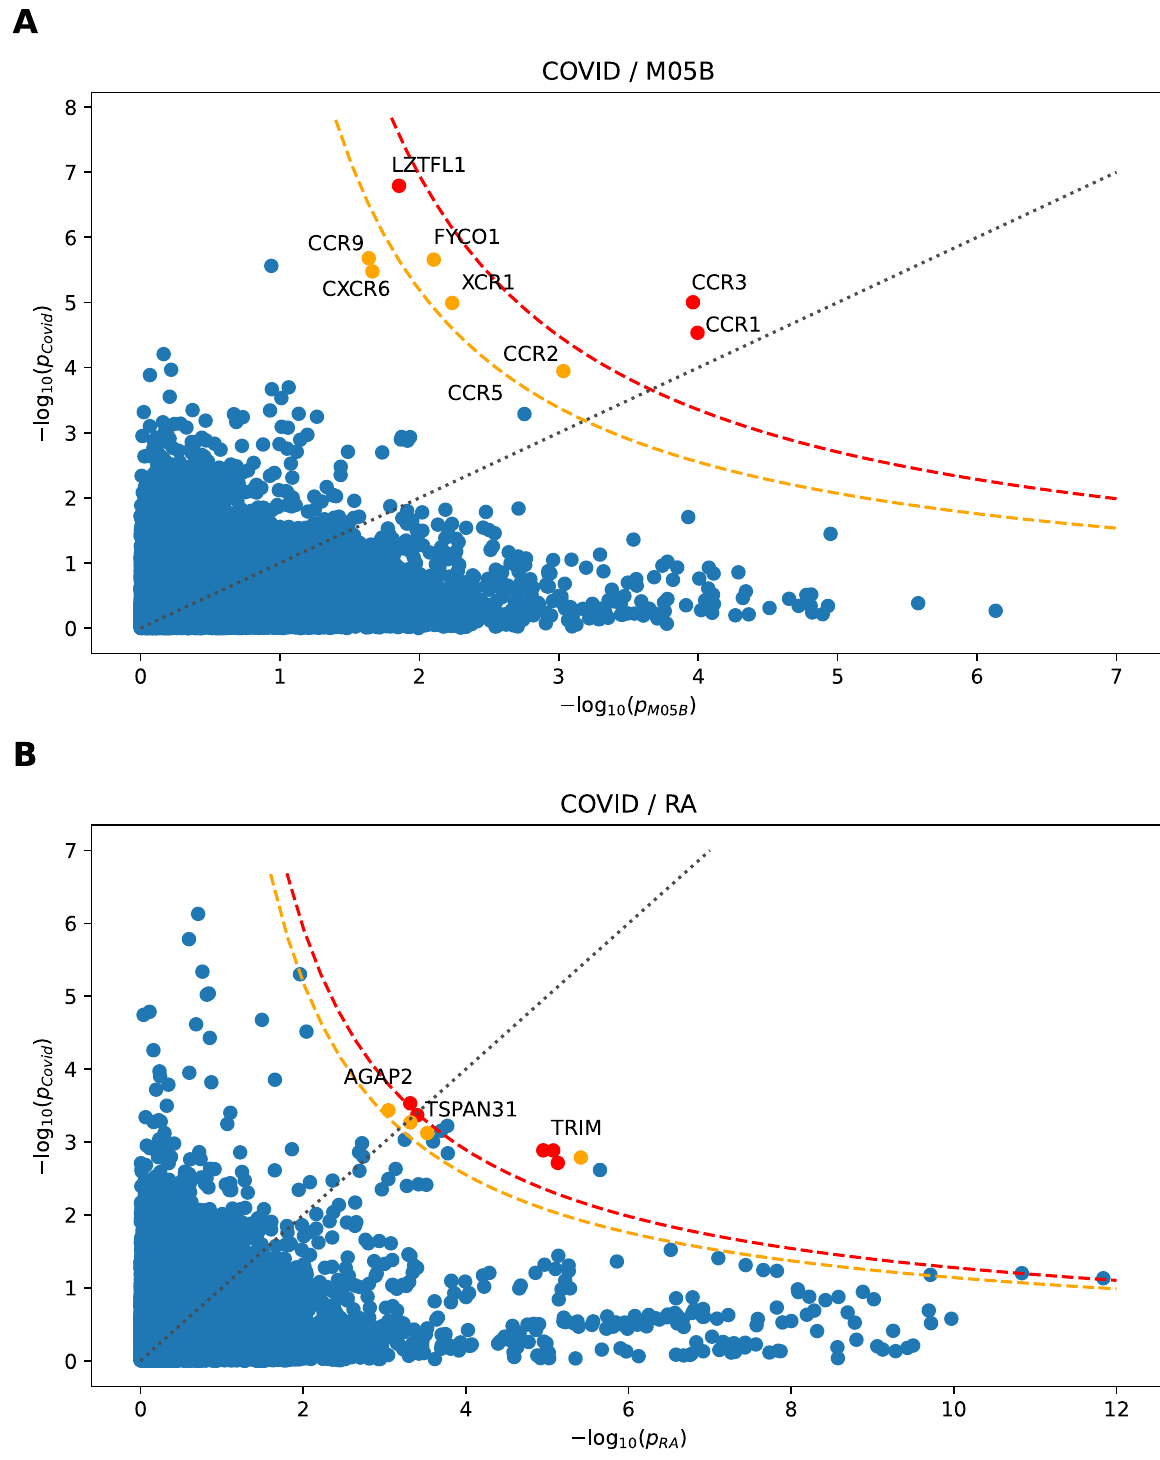
Fig 10. GWAS gene scores, obtained separately for two GWAS using joint qq-normalization and standard χ 2 based enrichment test, plotted against each other. Each point corresponds to a gene. The gray dotted line marks the diagonal corresponding to equal − log 10 p -values. The orange and red dashed curves mark the simple gene-wise product-normal threshold curves for significance of p < 10 − 6 and Bonferroni significance, respectively. The color of a gene (orange and red) indicates the full SNP-wise cross scored p -value ( p < 10 − 6 and Bonferroni significant,